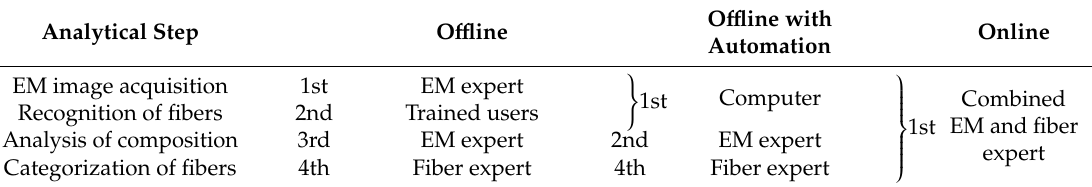
Table 10. Possible workflows for online, semi-automated and o ffl ine inspection of substrates containing fibers by morphological and chemical analysis using electron microscopy